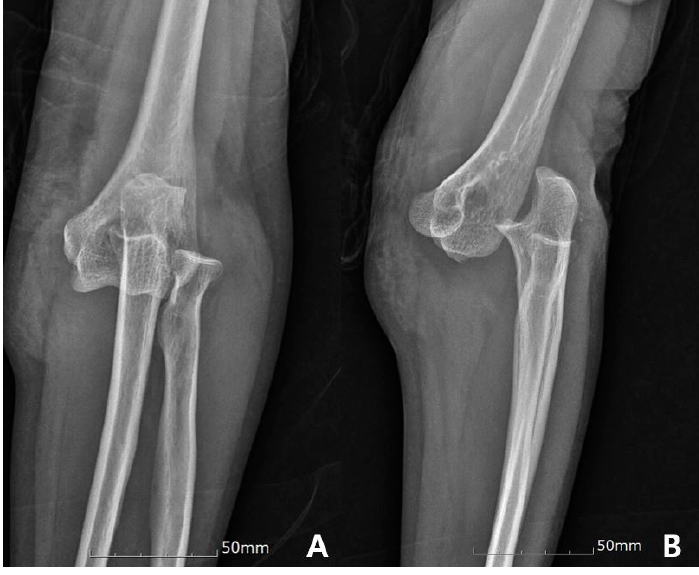
Figure 1. A 53-year old woman injured by slip down. Anteroposterior ( A ) and lateral ( B ) radiographs show simple posterolateral elbow dislocation.